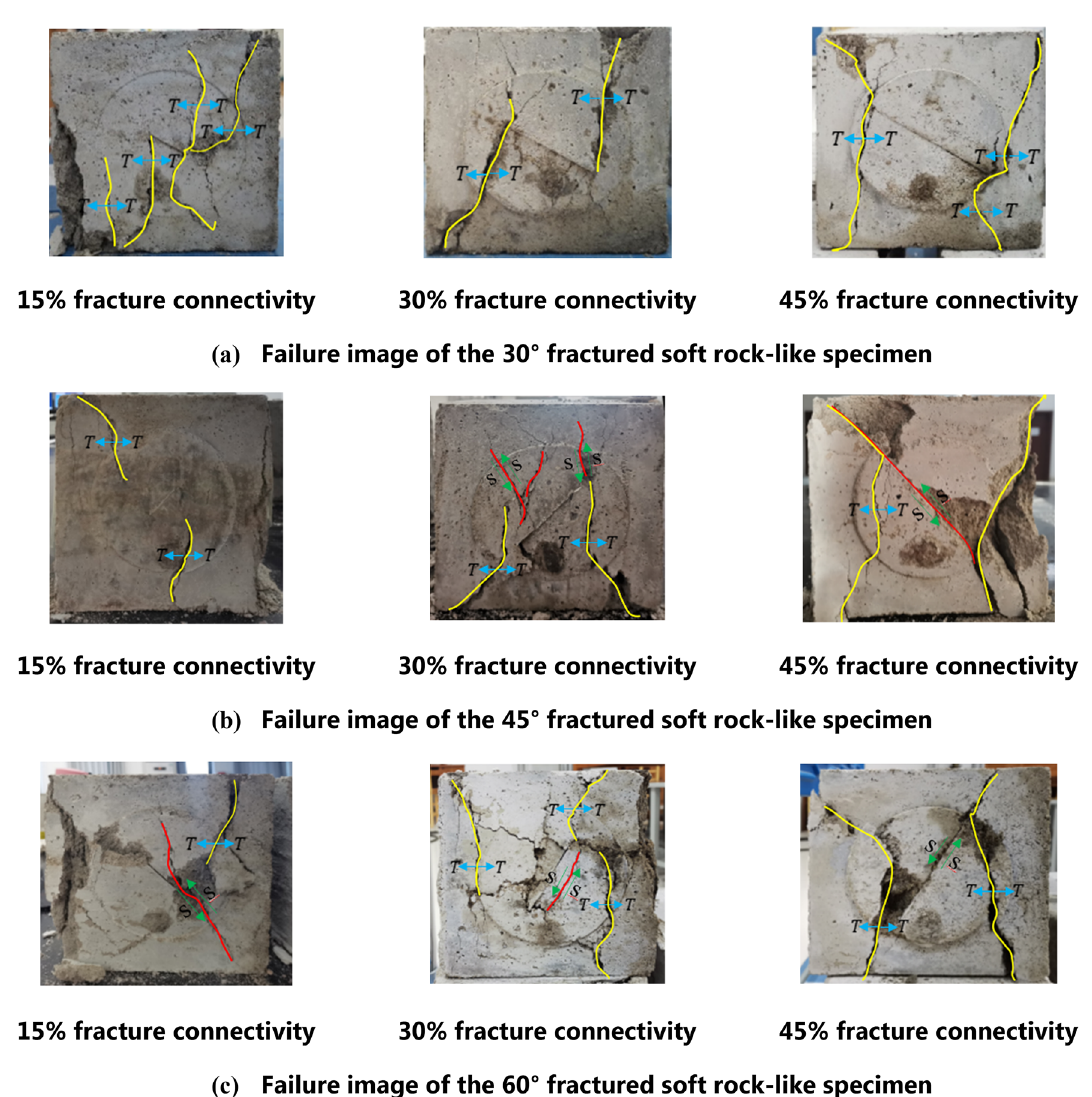
Figure 12. Failure images of the fractured rock specimens under uniaxial